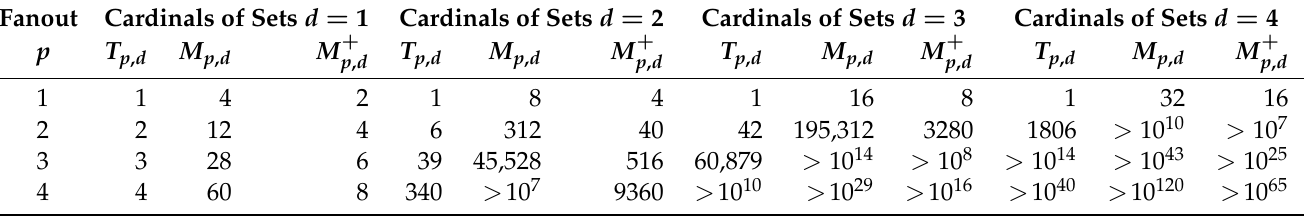
Table 1. Instances of the cardinals of the sets of rooted trees of depth d with fanout p , when marks are ignored ( T p , d ), when marks are in { 0,1 } ( M p , d ), and when leaves have mark 0 and other nodes have marks in { 0,1 } ( M + Fanout